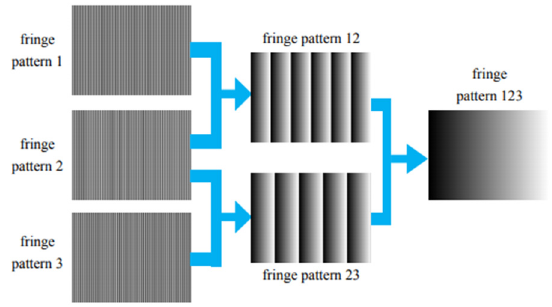
Figure 1. Principle of three-frequency heterodyne phase unwrapping.